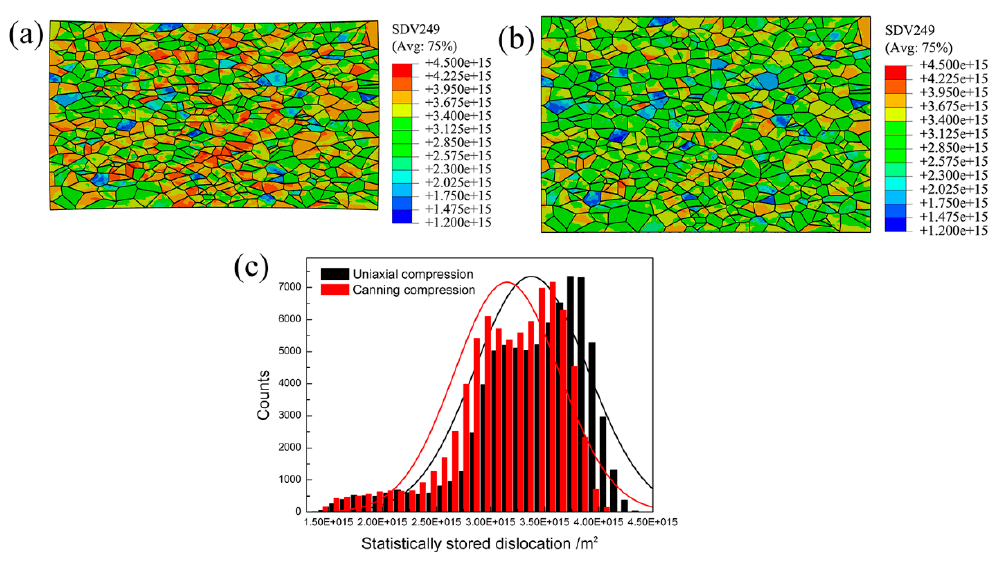
Figure 7. Contour plots of SSD density at the microscale level with the locations of the polycrystalline models corresponding to region 1 in Figure 4 during: ( a ) uniaxial compression process and ( b ) canning compression process; ( c ) Statistical analysis of SSD density in ( a , b ).